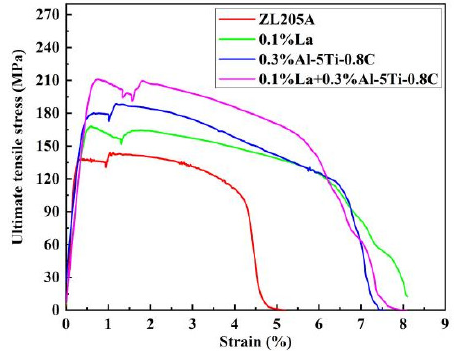
Figure 9. Tensile stress–strain curve of the alloys at 300 °C.